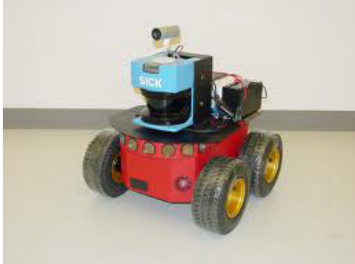
Figure 2. Picture of the mobile robot Pioneer 3AT used in this work. The range sensor laser is mounted on the